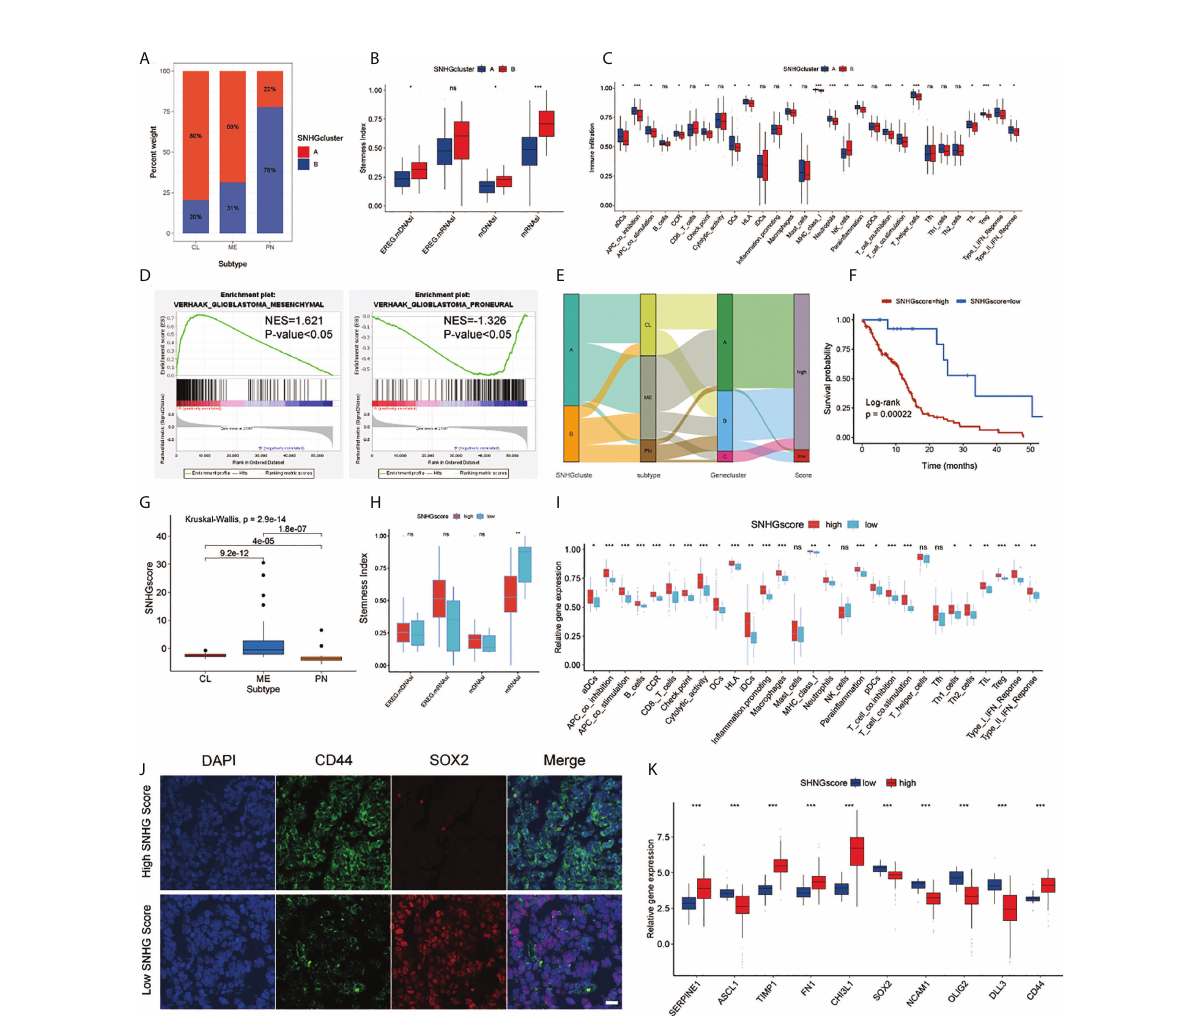
FIGURE 4 Analysis of SNHG interaction pattern and generation of SNHGscore. (A) The proportion of two interaction patterns in the three GBM subtypes. (B) Differences in stemness indices between the SNHGclusterA and SNHGclusterB. (C) The abundance of each immune signature in two SNHG interaction patterns. (D) GSEA reveals that SNHGclusterA is enriched in MES subtype and SNHGclusterB is enriched in PN subtype. (E) Alluvial diagram showing the changes of SNHG interaction patterns, GBM subtype, Geneclusters and SNHG scores. (F) Survival analyses for high SNHGscore and low SNHGscore GBM patients (P = 0.00022, Log-rank test). (G) Differences in SNHG scores among three GBM subtypes. (H) Differences in stemness indices between the high SNHGscore and low SNHGscore groups. (I) The abundance of each immune signature in the high SNHGscore and low SNHGscore groups. (J) IF staining was performed on GBM tissue sections of patients based on tissue sequencing (scale bar=15 m m). (K) The expression of MES/PN markers in high SNHGscore and low SNHGscore groups. All data are presented as the means ± SD, ns, P > 0.05, *P < 0.05, **P < 0.01, ***P <